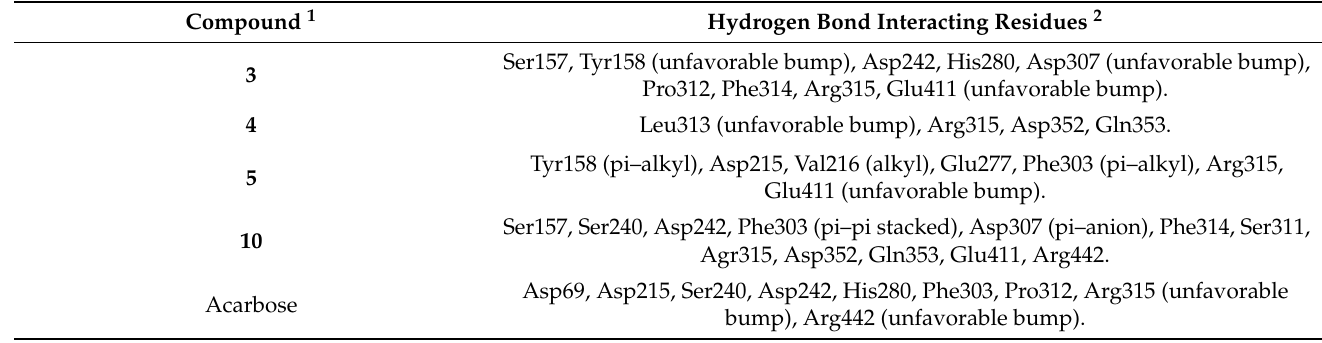
Figure 4. Compound 5 (green — most active) and acarbose (gray — control) at the active site of α - glucosidase. Table 3. Interaction residues of compounds obtained from molecular docking simulation.